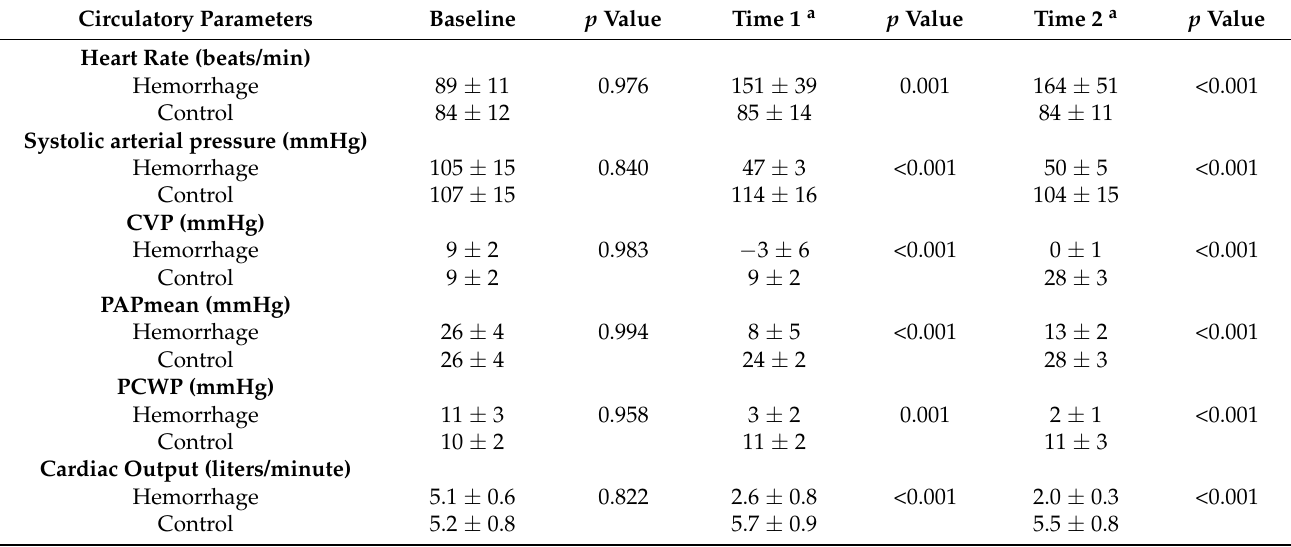
Table 2. Circulatory parameters in acute hemorrhagic